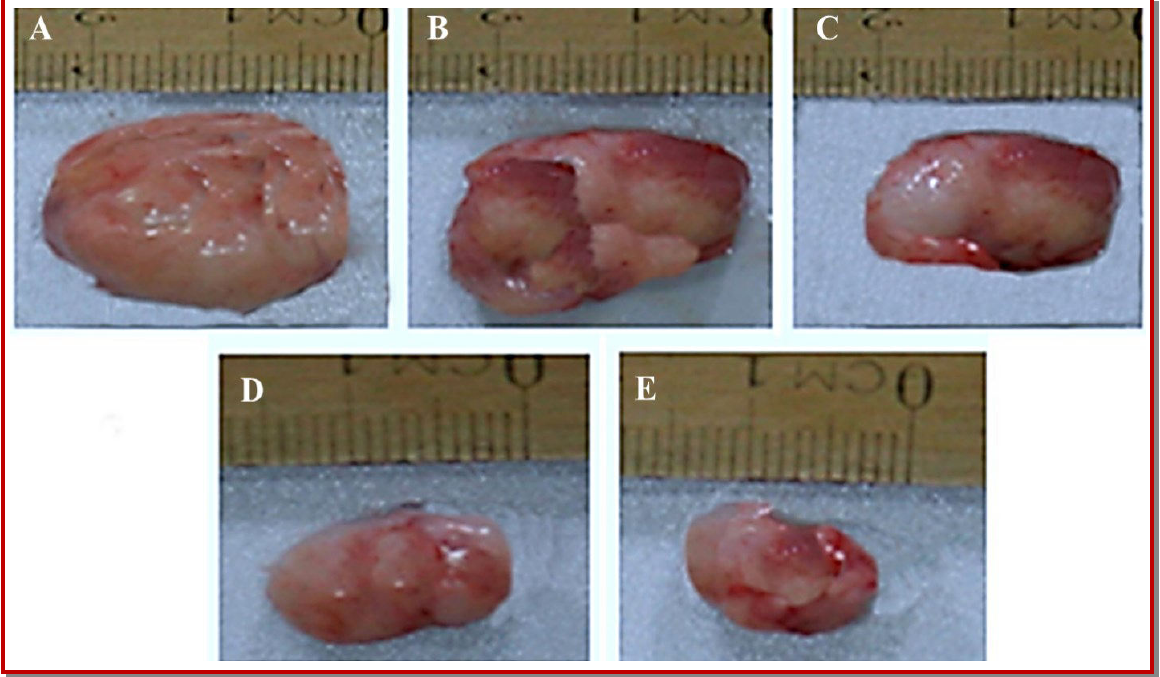
Figure 5: In vivo anti-cancer activity of naringenin chalcone on U87MG human glioblastoma cells in xenograft mice model. Cancer- ous Xenografts from U87MG human glioblastoma cells were incorporated in nude mice. The mice were treated with either vehicle control or naringenin chalcone for 8 days. A, shows vehicle control group, B, shows naringenin chalcone-treated group with 5 mg/kg dose, C, naringenin chalcone-treated group with 20 mg/kg dose, D, naringenin chalcone-treated group with 40 mg/kg dose, E, naringenin chalcone-treated group with 80 mg/kg